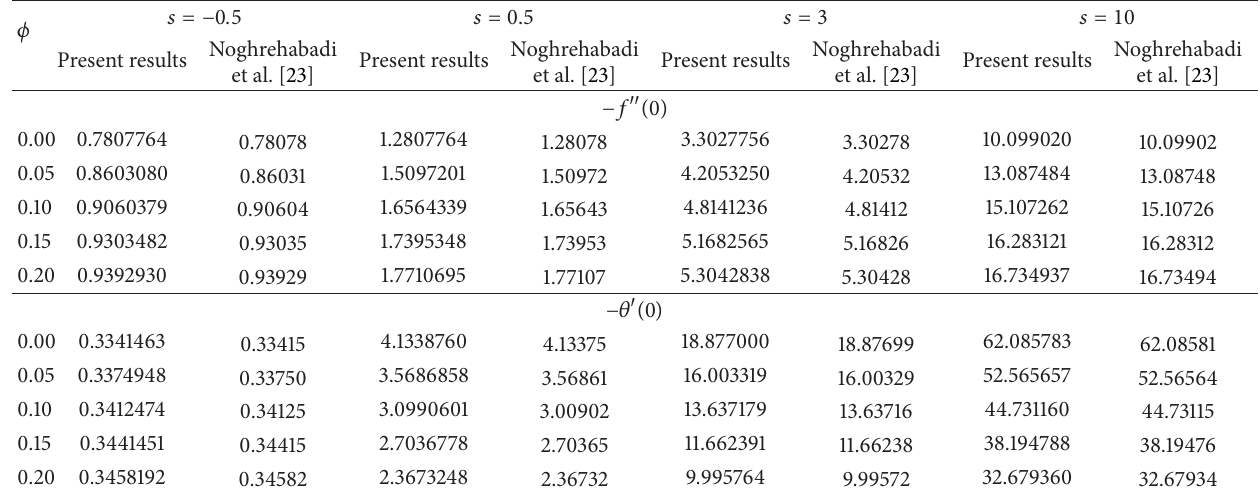
Table 4: Comparison between the results of −𝑓 󸀠󸀠 (0) and −𝜃 󸀠 (0) for Ag-water nanoparticles when Pr = 6.2 and 𝛿 1 = 𝛿 2 = 0 .